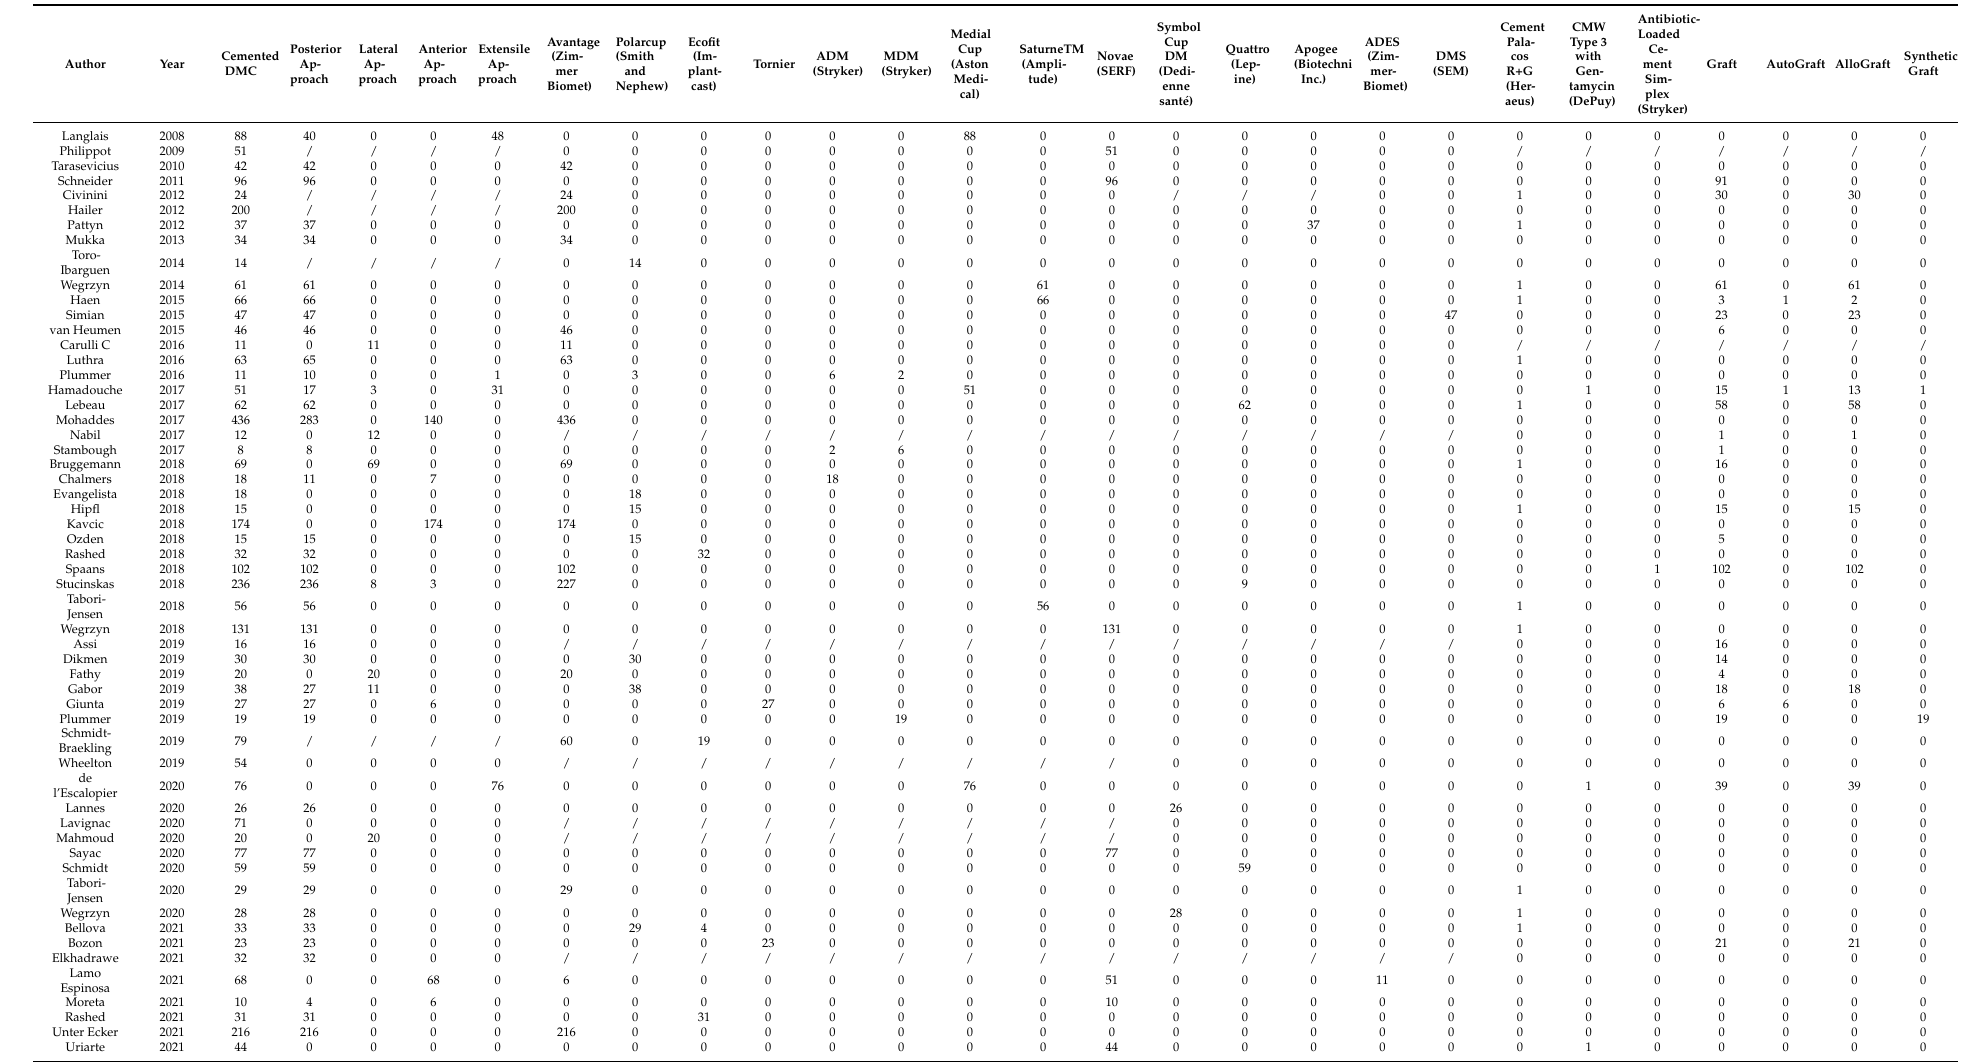
Table 2. Cemented dual mobility cup: surgical